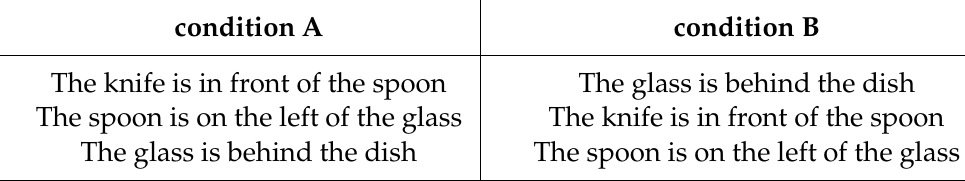
Table 1: Experimental Conditions in Johnson-Laird (1980)